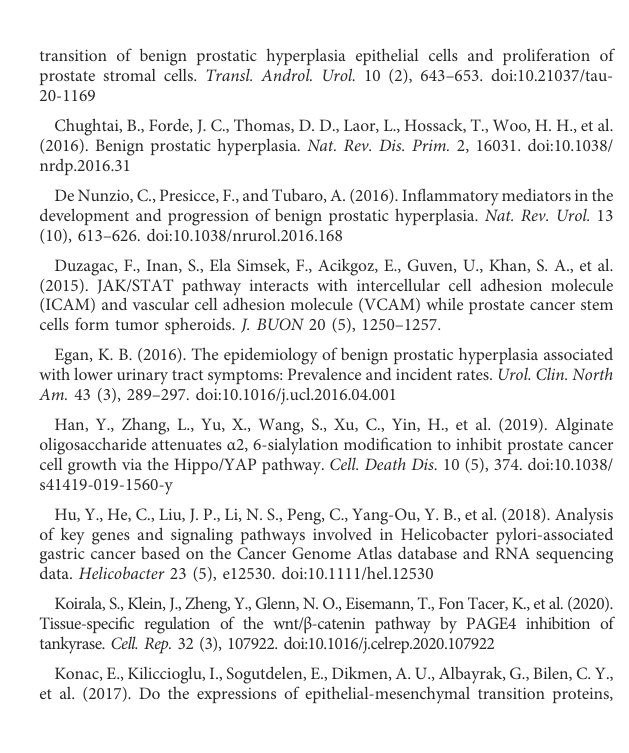
SUPPLEMENTARY FIGURE S1 Microscopic morphology of primary prostatic stromal cells. SUPPLEMENTARY FIGURE S2 Veri fi cation of RNA-seq results by qPCR. A and B: qPCR comparison of 10 signi fi cantly upregulated DEGs in PrSCs with TGF β 1 and without TGF β 1 (Control). C and D: qPCR comparison of 10 signi fi cantly downregulated DEGs in PrSCs with TGF β 1 and without TGF β 1 (Control). SUPPLEMENTARY FIGURE S3 Scatter plot for KEGG enrichment results. The signi fi cant 29 enrichment pathwaysareshownintheseniorbubblechart.TheRichRatioistheratio of DEG numbers annotated in this pathway term to all gene numbers annotated in this pathway term. A Q-value is the corrected p-value. SUPPLEMENTARY FIGURE S4 Protein – protein interaction network for DEGs. Each node displays different depth colors according to its degree score. From the inside to the outside, the degree decreases and the color changes from dark to light. SUPPLEMENTARY TABLE S1 All details of DEGs in PrSCs with and without TGF β 1 treatment. SUPPLEMENTARY TABLE S2 Details related to KEGG pathways. SUPPLEMENTARY TABLE S3 Top 13 genes in the protein – protein interaction network (node degree ≥